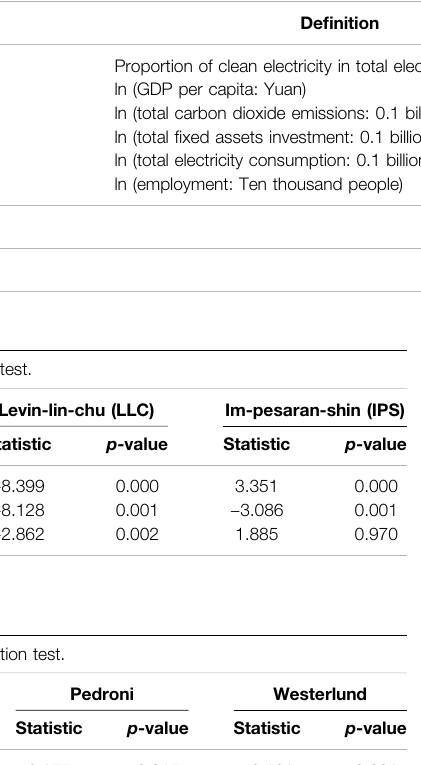
TABLE 1 | Description and de fi nition of variables 3 .